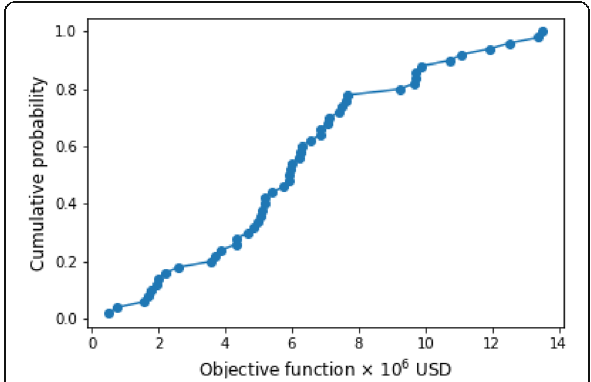
Fig. 4 Cumulative probability distribution of the objective